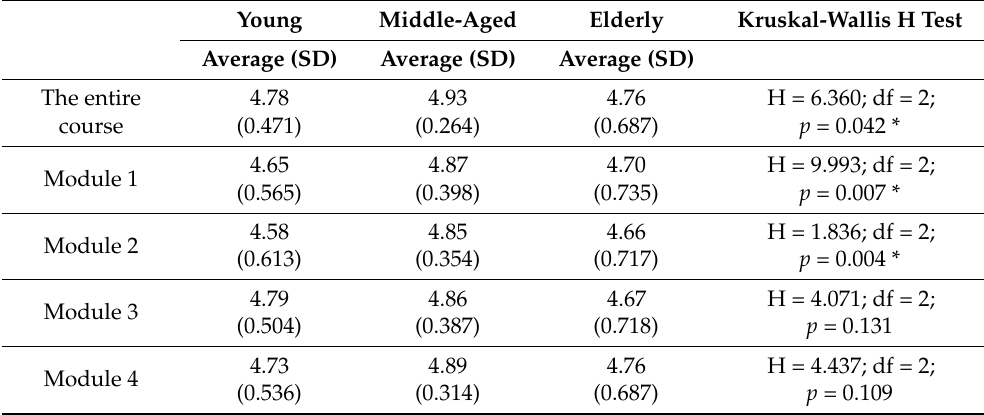
Table 3. Participant ratings by age